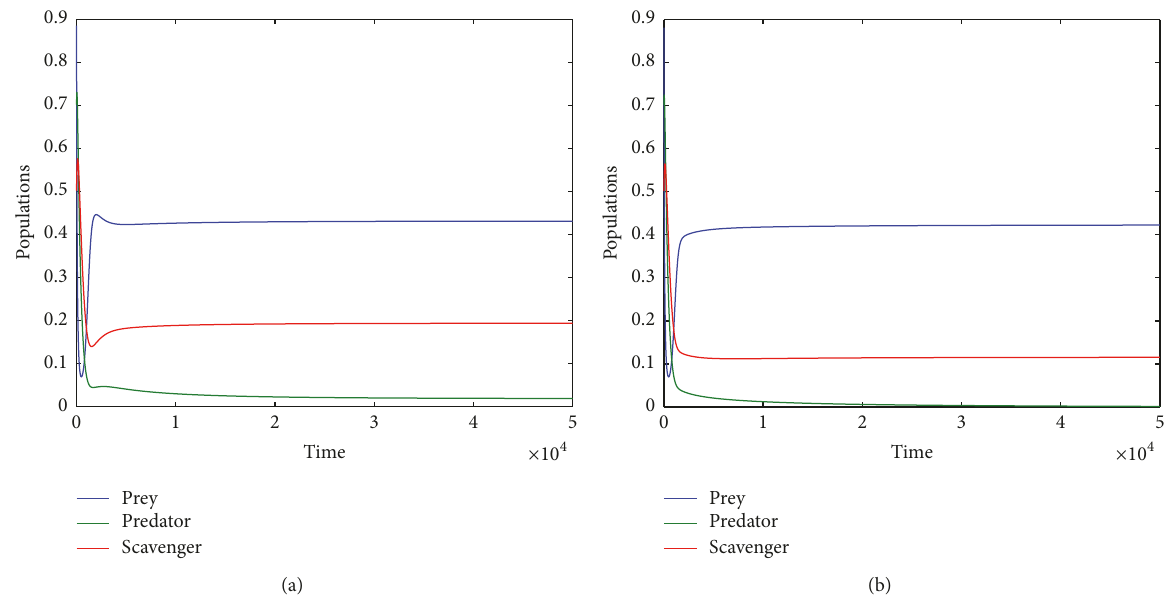
Figure 10: Time series for the solution of system (3) using data (76) with varying some parameters. (a) The system approaches positive equilibrium point 𝐸 4 = (0.43,0.02,0.19) for 𝛼 = 0.3 , 𝛽 = 0.3 , 𝜂 = 0.2 . (b) The system approaches predator free equilibrium point 𝐸 2 = (0.42,0, 0.11) for 𝛼 = 0.3 , 𝛽 = 0.9 , 𝜂 = 0.2